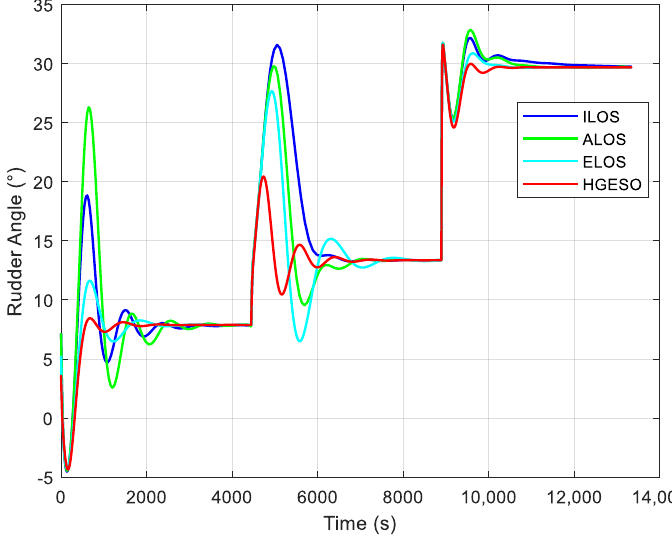
Figure 5. Comparison of rudder angle with different guidance laws at y d = 0.1 L Table 2. Comparison of overshoot and settling time at 0.1